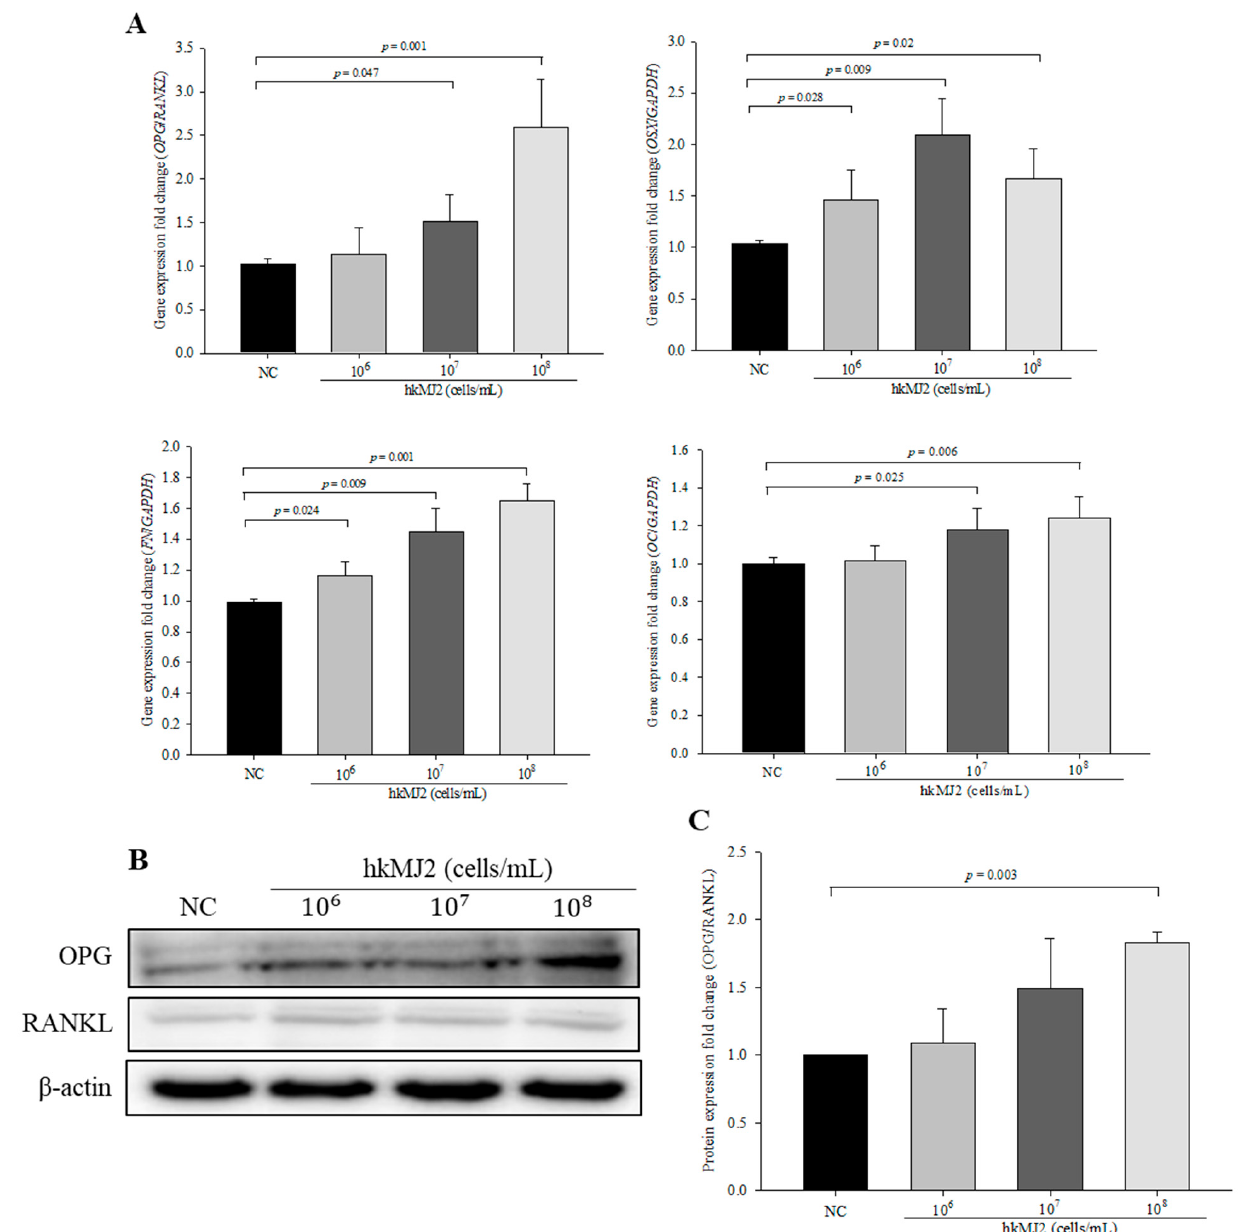
Figure 3. Expression levels of osteoblast differentiation-related genes and proteins in cells treated with heat-killed P. freudenreichii MJ2 (hkMJ2). The expression levels of genes were measured by qPCR ( A ) and proteins were measured by Western blotting ( B ) and quantified ( C ). The values indicate the mean ± SD of three independent experiments performed in triplicate.